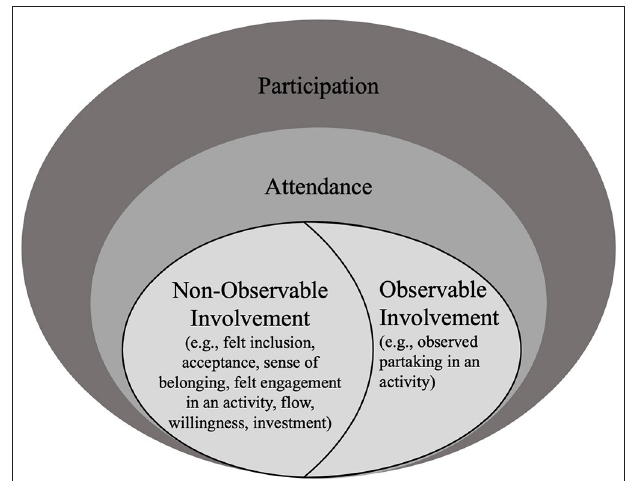
FIGURE 3 | Participation encompassing observable and non-observable parts of involvement. Informed by the family of Participation-Related Constructs (fPRC) ( 2, 3) and research on the conceptualization of involvement ( 2, 3, 6–8, 72,